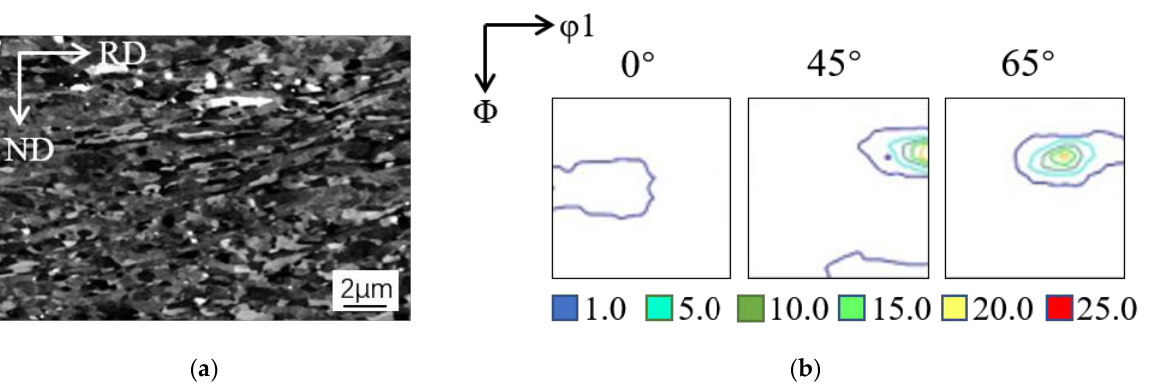
Figure 2. ( a ) SEM micrograph and ( b ) texture distribution (φ 2 = 0°, 45°, 65°) of cold-rolled Al-0.5%Cu.